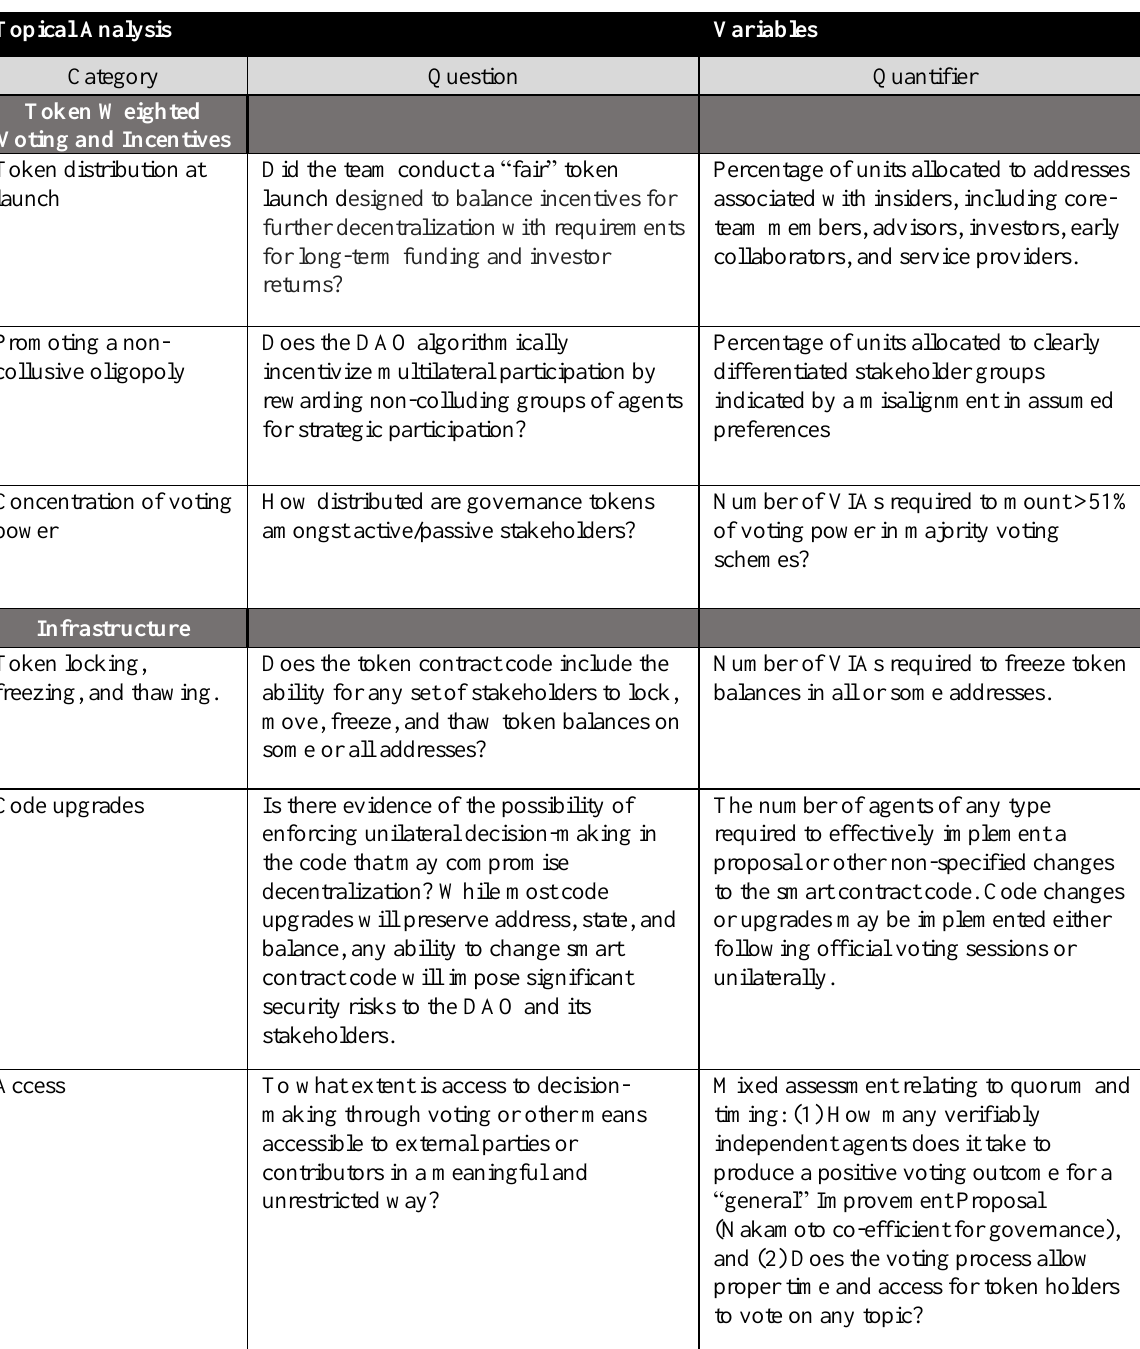
Table 3. TIGER Assessment